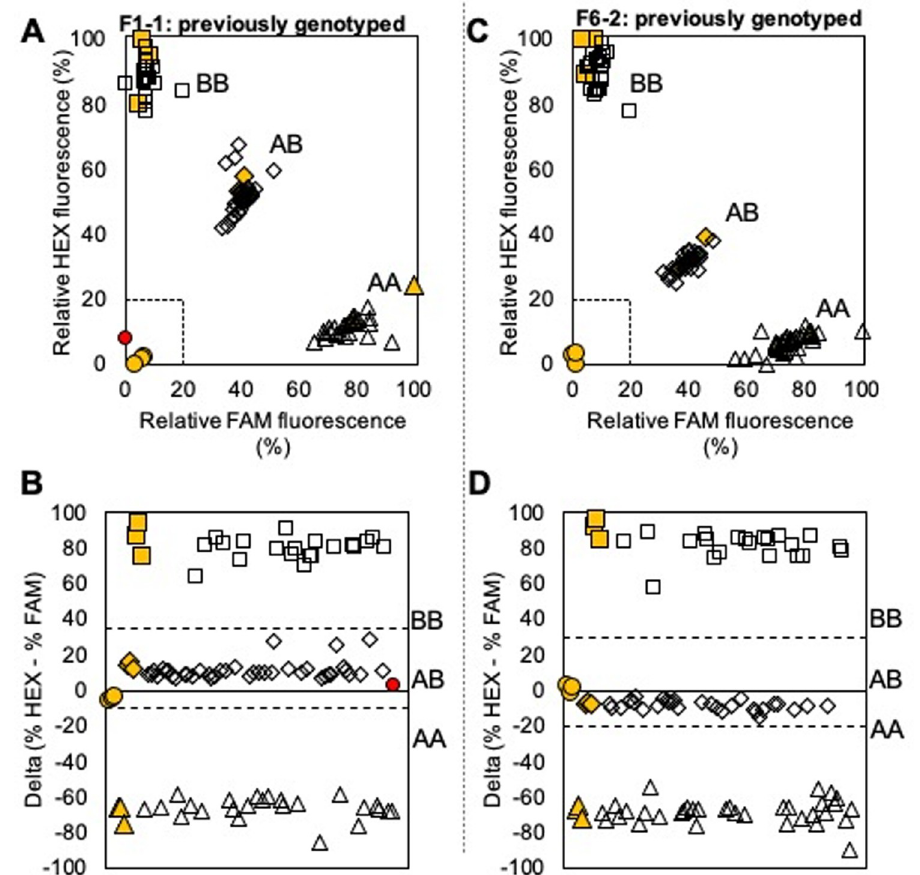
Fig 3. Results from KASP assays for two SNPs, Ppe.Xap F1-1 and Ppe.Xap F6-2, using endpoint PCR with previously genotyped samples. Solid yellow shapes indicate positive controls, solid red indicates an unknown that failed to amplify, and empty shapes indicate unknowns, with the shape indicating the assigned genotype as follows: circle = no template/no amplification, triangle = AA, diamond = AB, square = BB. Dashed lines in plots in the top row indicate boundaries for no amplification (% fluorescence < ~20% for both fluorophores). Dashed lines in plots in the bottom row indicate delta (% HEX—% FAM) values separating heterozygous and homozygous genotypes, adjusted to reflect assay